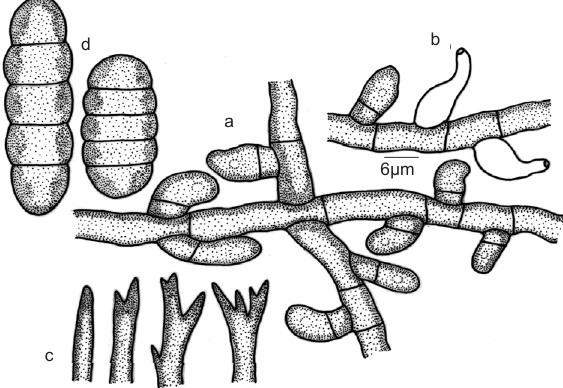
Figure 4. Meliola filicii Hosag. var. indica var. nov. a - Appressorium; b - Phialide; c - Apical portion of the mycelial